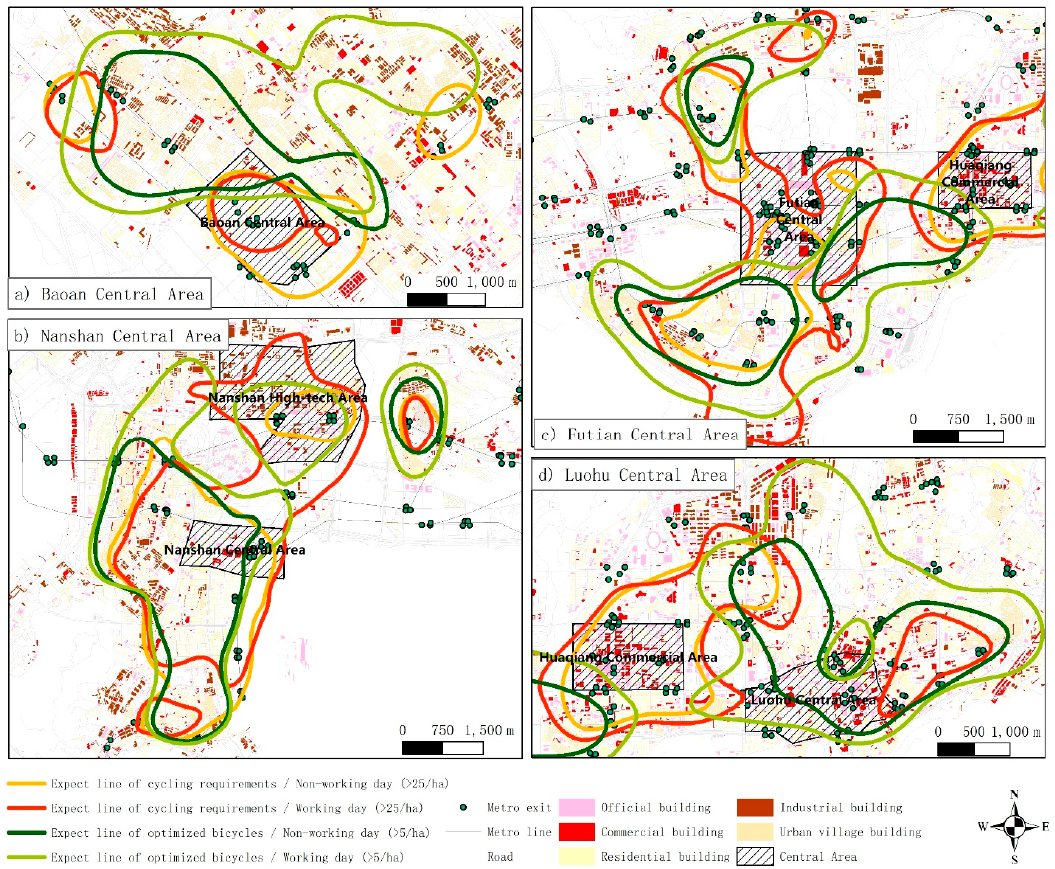
Figure 7. Built environments in six central areas with high requirement or supply spaces for shared bikes.